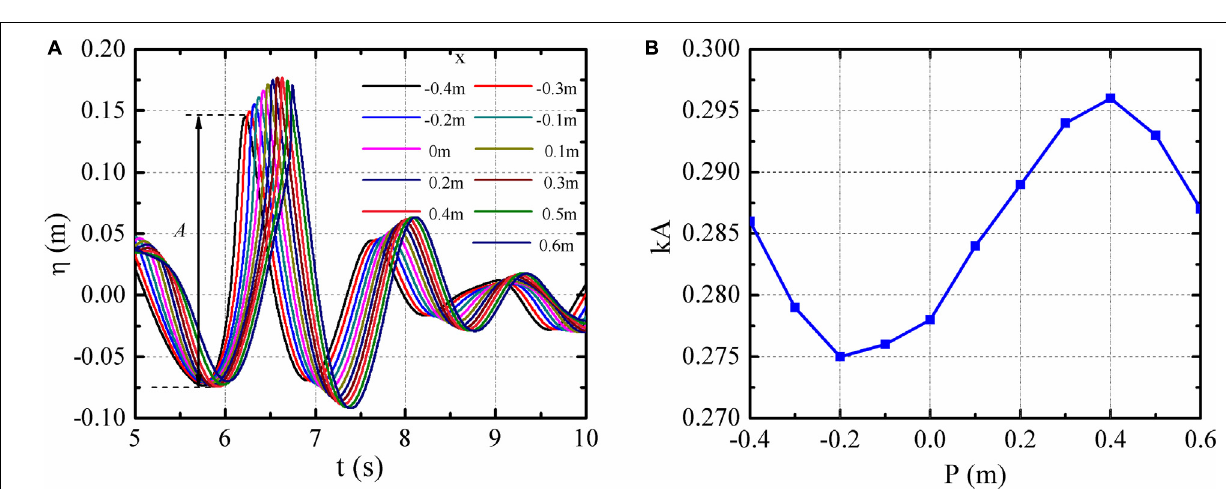
Frontiers in Marine Science |